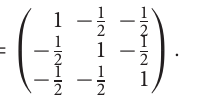
of all three-strategy elementary coordination games.